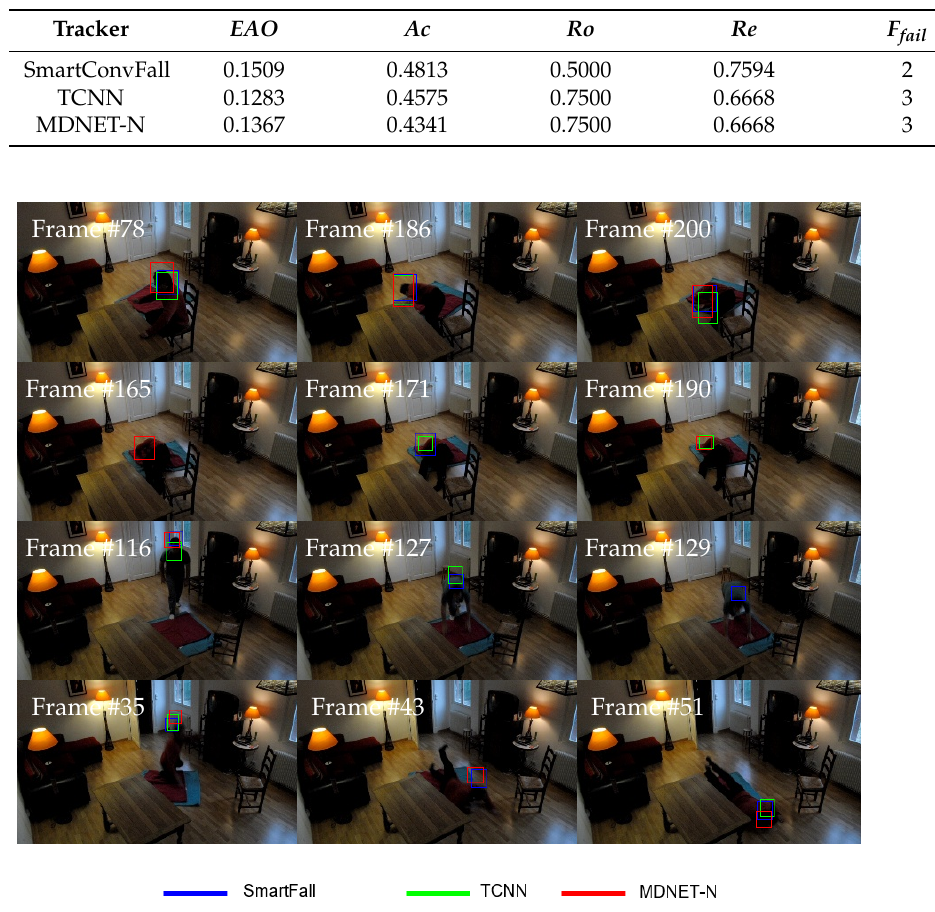
Figure 19. Comparison of B output of all tested trackers for the cluttered background